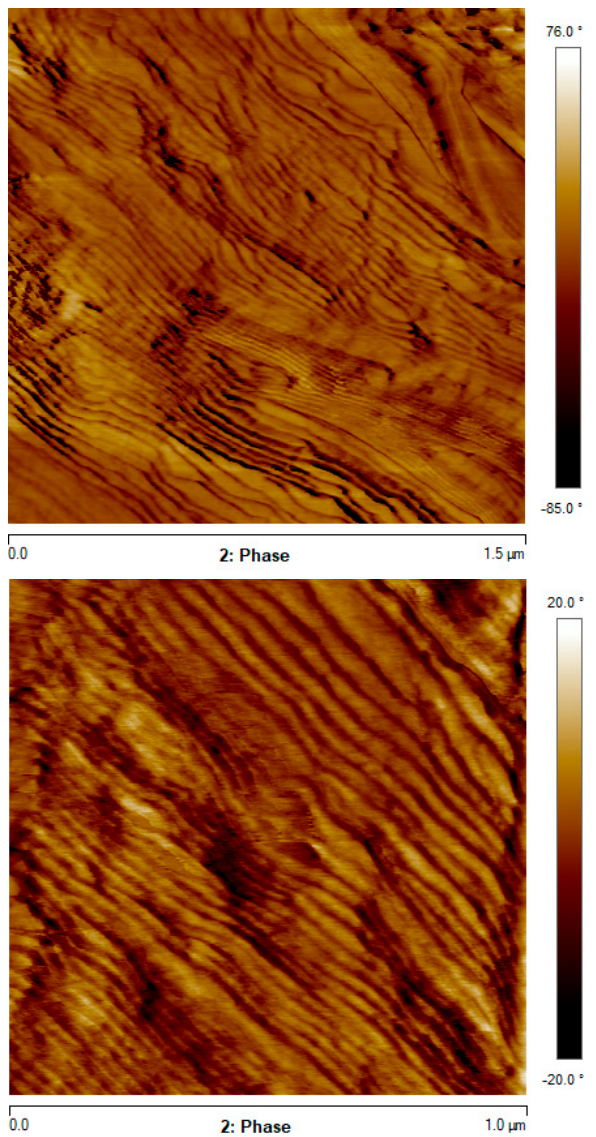
Figure 11. Two representative AFM phase images of neat PA6 taken from the surface of ultra- microtomed